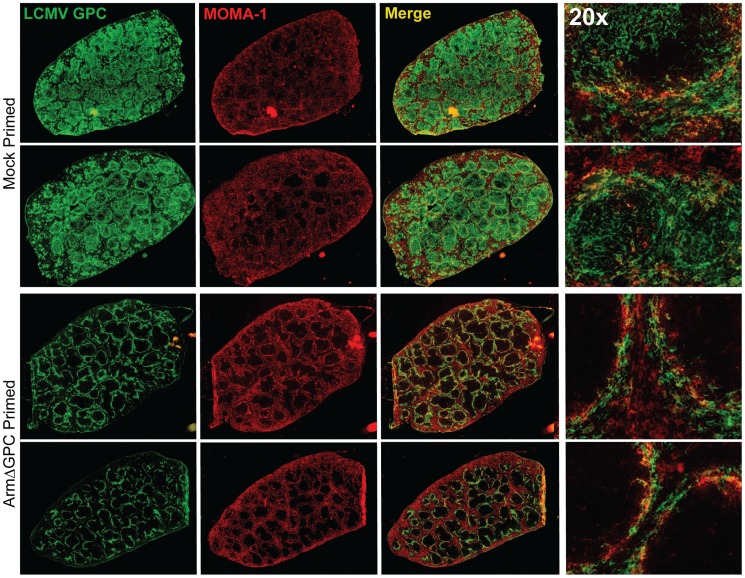
Differential localization of viral antigen in spleens of primed and mock primed Cl13 infected mice.C57Bl6/J mice (n = 3/group) were primed, infected and spleens were harvested as in Fig. 4 at 72 hours post-infection. Spleens were flash frozen in OCT and 6–8 µm sections were prepared and stained with a guinea pig serum to LCMV GPC (green). Splenic microarchitecture was assessed by visualization of mellalophilic macrophages using anti mouse MOMA-1 antibodies (red). Sections from two mice/group are shown here and are representative of the group as a whole. Data are from one of two independent experiments.